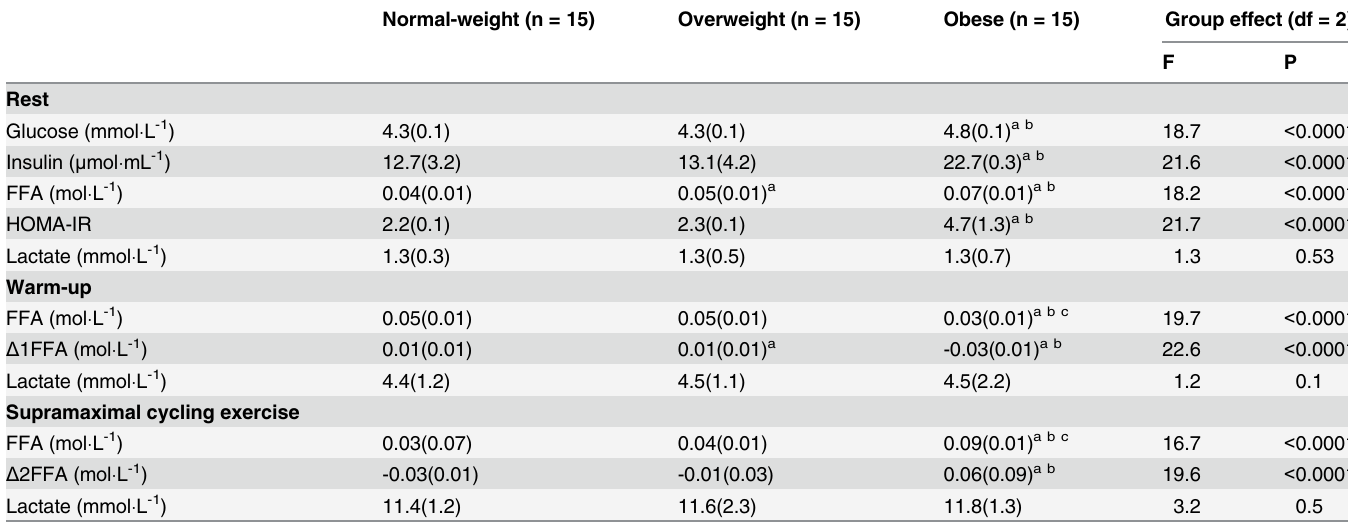
Table 2. Metabolic parameters of adolescent